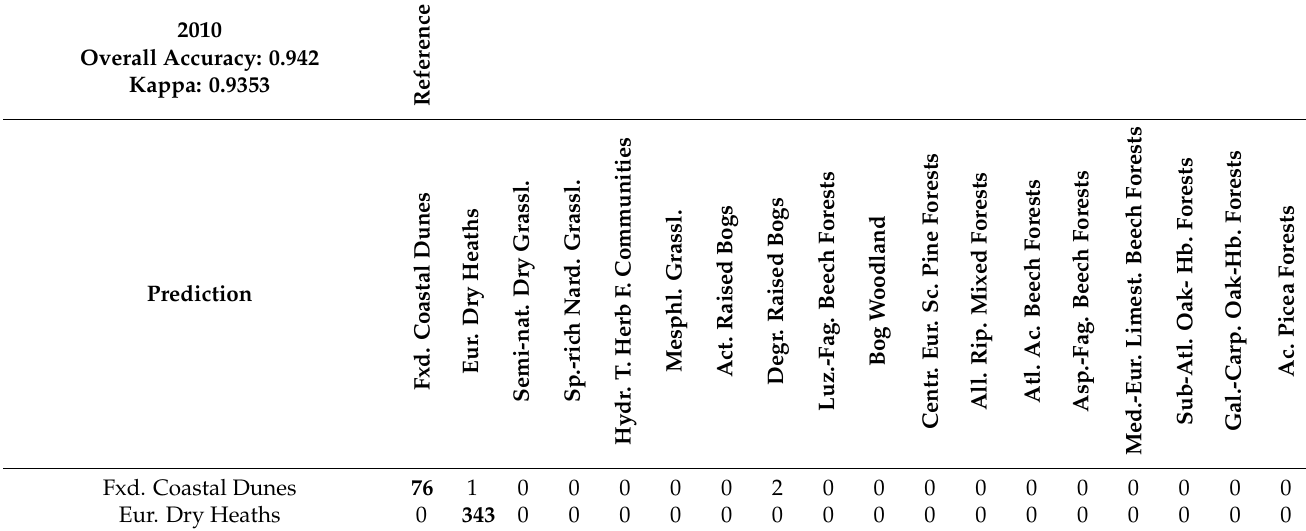
Table A3. Confusion matrix for